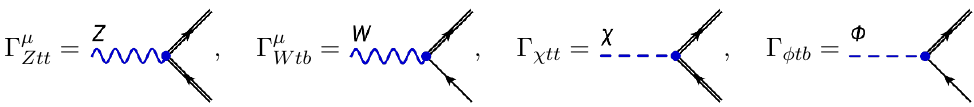
Figure 1 . Electroweak top quark interactions that receive modi(cid:12)cations from dimension-six oper- ators in our